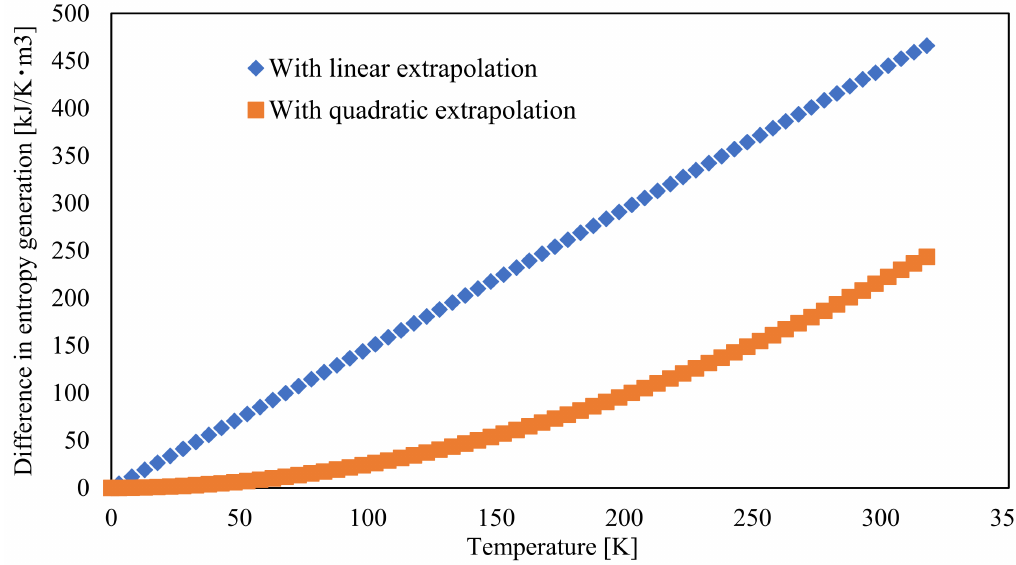
Figure 8. Thermalentropy generation before and after tensile deformation with linear and quadratic